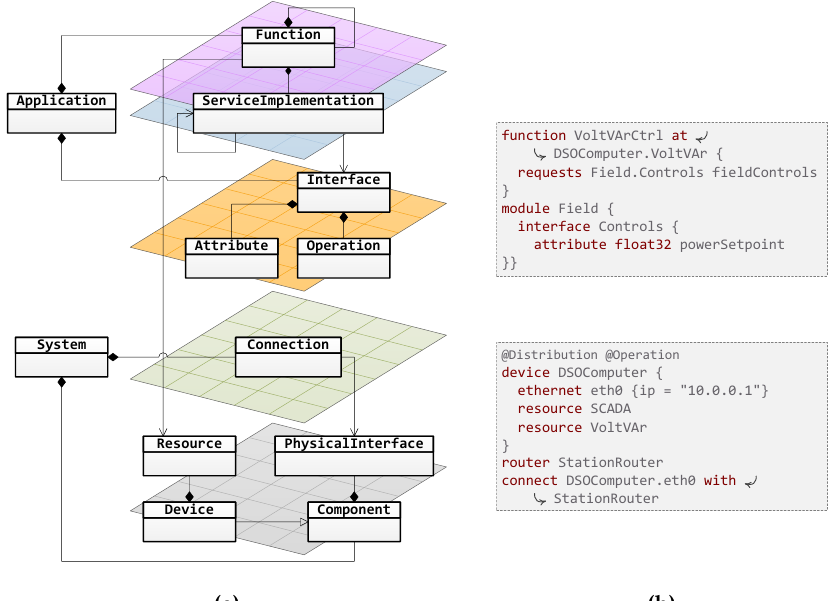
Figure 6. The PSAL engineering approach: ( a ) UML (Unified Modeling Language) representation; and ( b ) example code